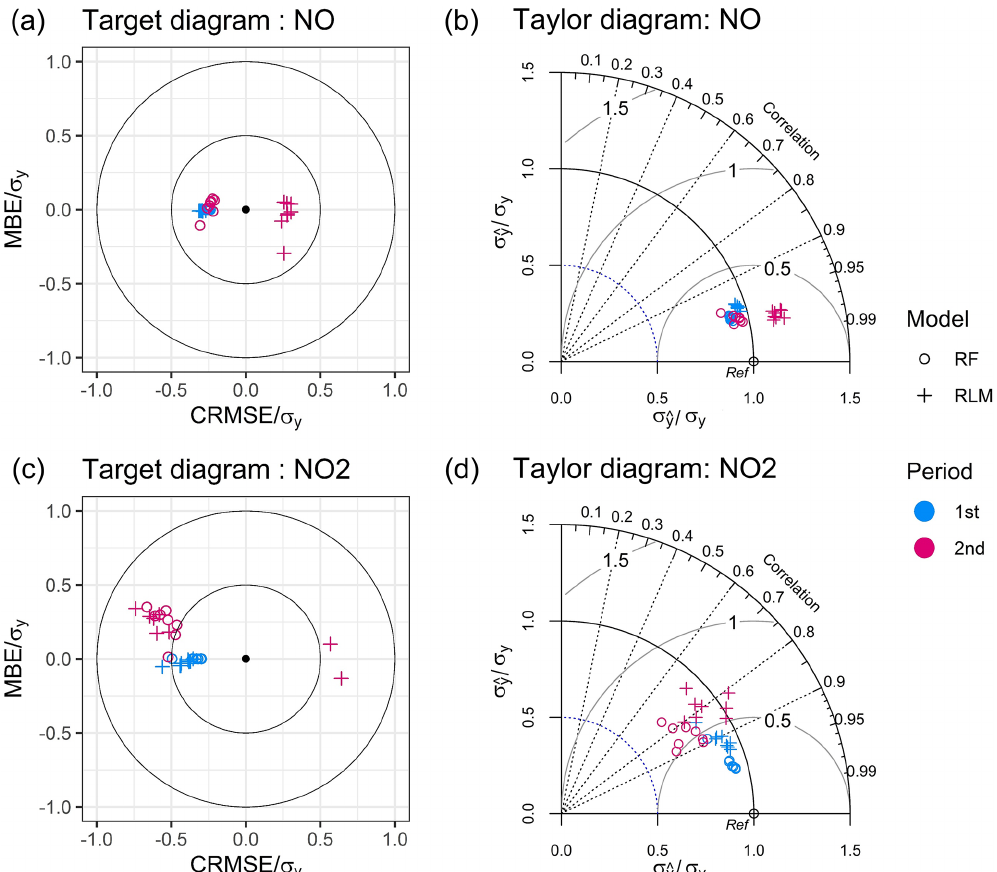
Figure 5. Target diagrams ( a and c ) and Taylor diagrams ( b and d ) of each pollutant during the calibration evaluation period (first) and the sensor relocation period after the deployment (second). In the target diagram, the centered root mean square error (CRMSE) normalized by the standard deviation of reference data ( σ y ) is stated on the x axis, whereas the normalized mean bias error (MBE /σ y ) is stated on the y axis. A distance from the origin indicates the nRMSE. Note that by convention the sign of CRMSE /σ y in target diagrams is determined by the sign of ( σ ˆ y − σ y ). A Taylor diagram illustrates three statistical metrics (Taylor, 2001): (1) Pearson’s correlation coefficients ( r ) are presented as the azimuthal angles from the y axis. (2) Normalized standard deviations ( σ ˆ y /σ y ) of models are given as the distance from the origin. (3) CRMSE is proportional to the distance between the data points and the reference point (Ref) on the x axis. The reference point (Ref) is the point where an ideal sensor ( r = 1, σ ˆ y /σ y = 1) is located in Taylor